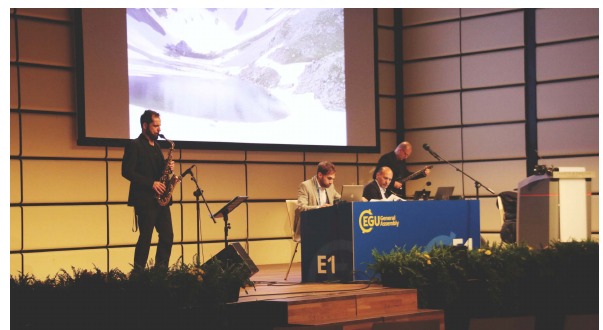
Figure 5. A moment from the “Sounds from the Geology of Italy” show at the EGU General Assembly